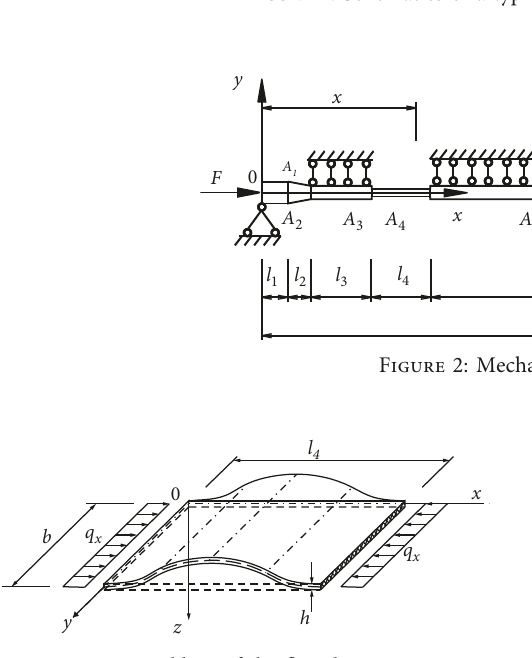
Figure 1: Schematics of a typical BRB-VCC. (a) BRB-VCC. (b) Core.